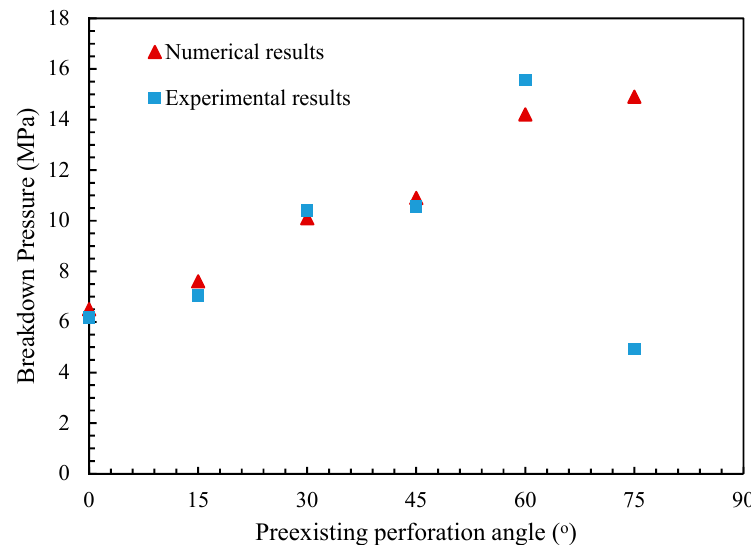
Figure 8. Comparison of experimental results and numerical results for breakdown pressures.